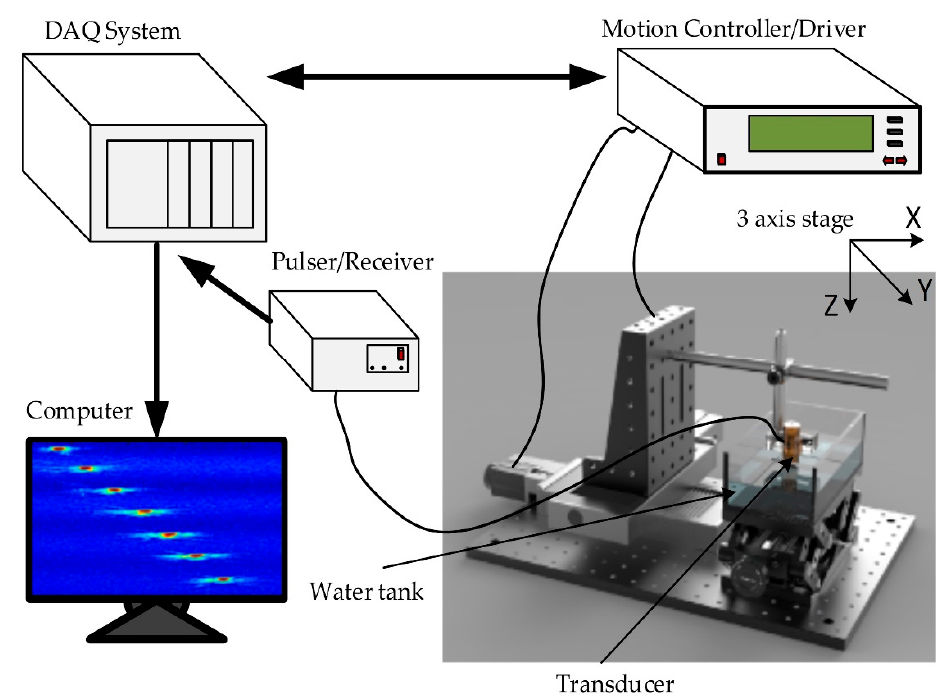
Figure 9. A schematic of the experimental ultrasound system.